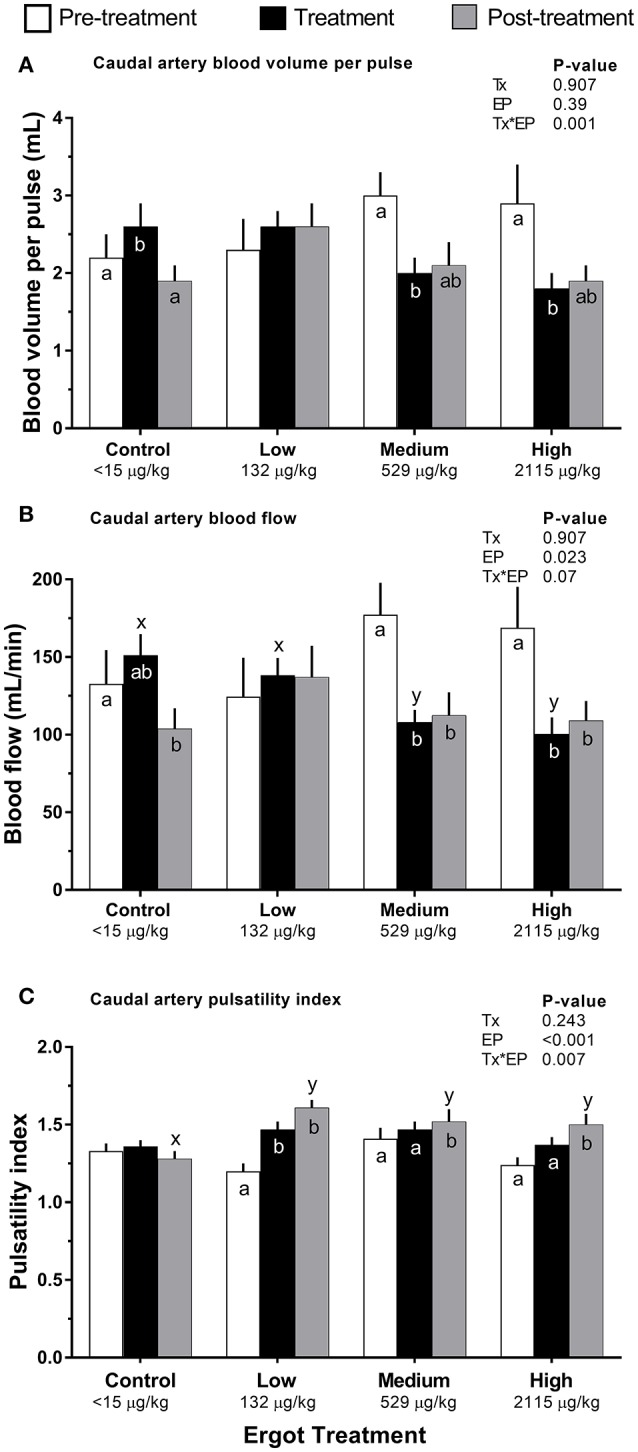
Caudal artery hemodynamic parameters of lactating Hereford cows (n = 4 per treatment group) before (4 days, white bars), during (7 days; black bars), and after (4 days, gray bars) feeding increasing concentrations of ergot alkaloids in Control (<15 μg/kg), Low (132 μg/kg), Medium (529 μg/kg), and High (2115 μg/kg) ergot groups. (A) pulsatility index (unitless) (B) blood volume per pulse (mL), and (C) blood flow (mL/min). Data are presented as the mean±SEM for each experimental period. Differences among experimental periods within a treatment group (connected bars) are indicated by x and y (p < 0.05) and differences among groups during a given treatment period (same colored bars) are indicated by a and b (p < 0.05).